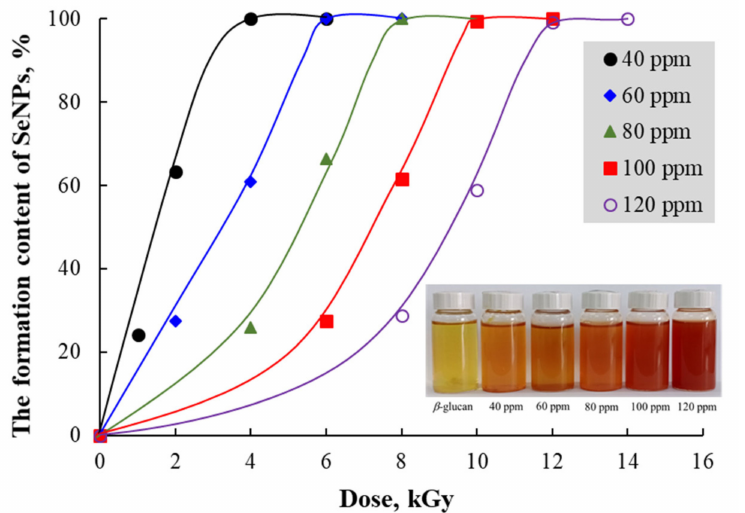
Figure 1. The saturated dose for radiation synthesis of SeNPs/ β -glucan samples with various Se 4+